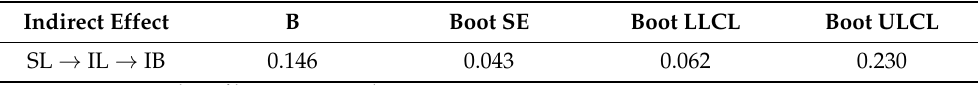
Table 5. Bootstrapping results on mediating effects of informal